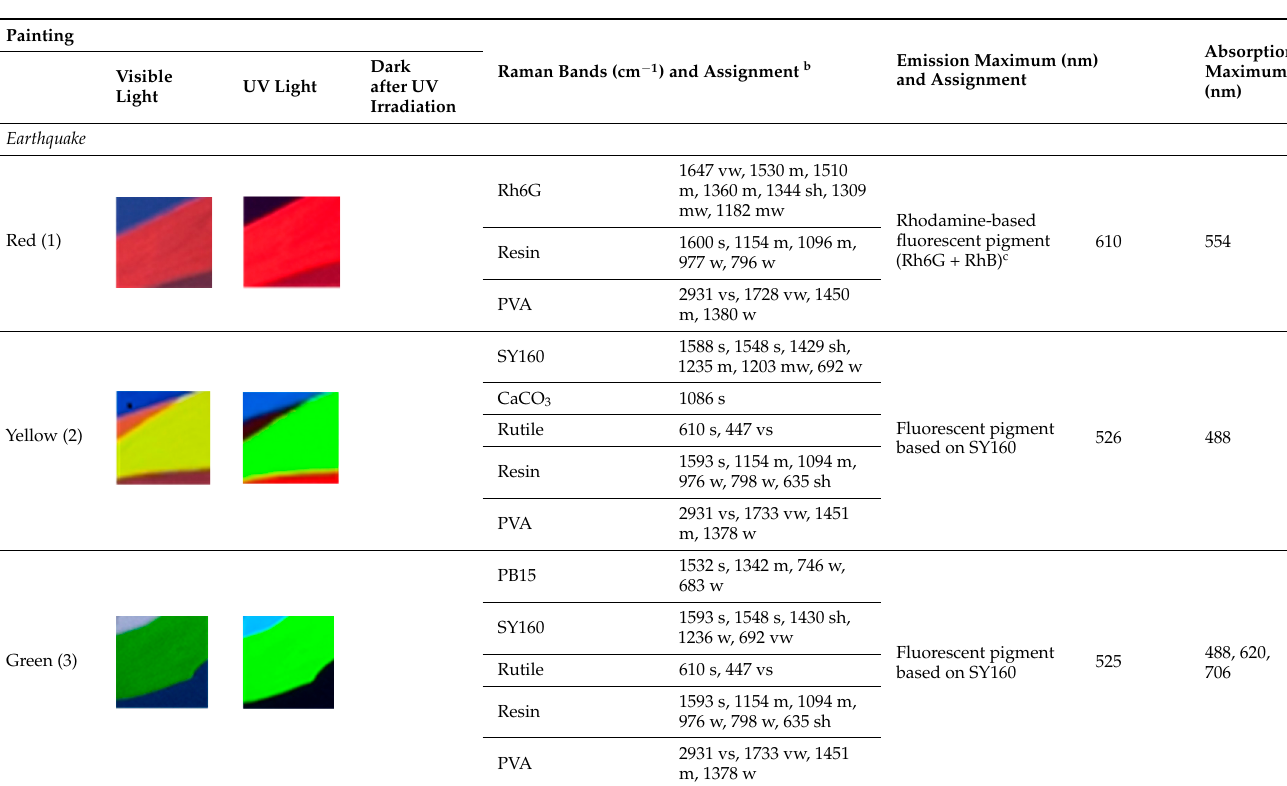
Figure 1. SSE™ Raman spectra of red areas: ( a ) The grammar of fire—Canto I , area 1, (b) The grammar of fire—Canto II , area 2, ( c ) The North star and the tree of life , area 1, ( d ) The North star and the tree of life , area 6 (orange) and ( e ) Earthquake , area 1. Legend: = pigment (for wavenumbers and assignments see Table 2), * = rutile, = CaCO 3 , = resin, (cid:0) = Sr 2 MgSi 2 O 7 , = ZnS, = binder (see text).